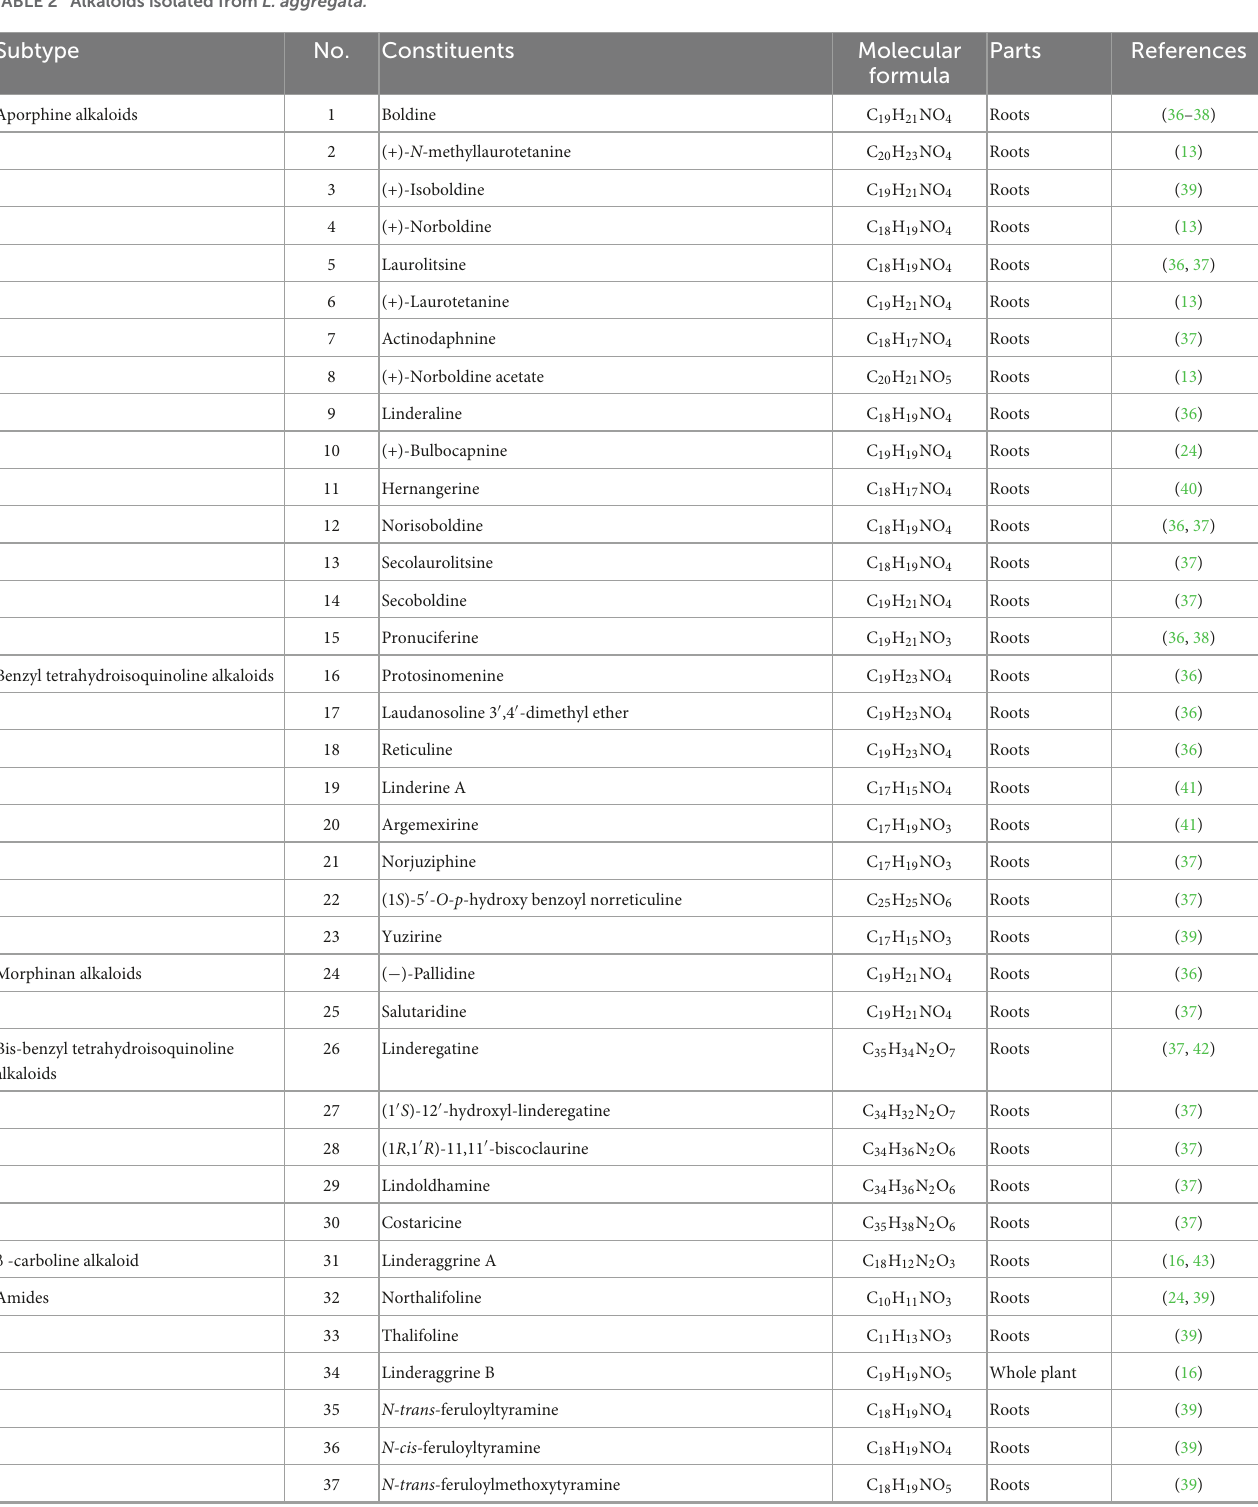
TABLE 2 Alkaloids isolated from L.